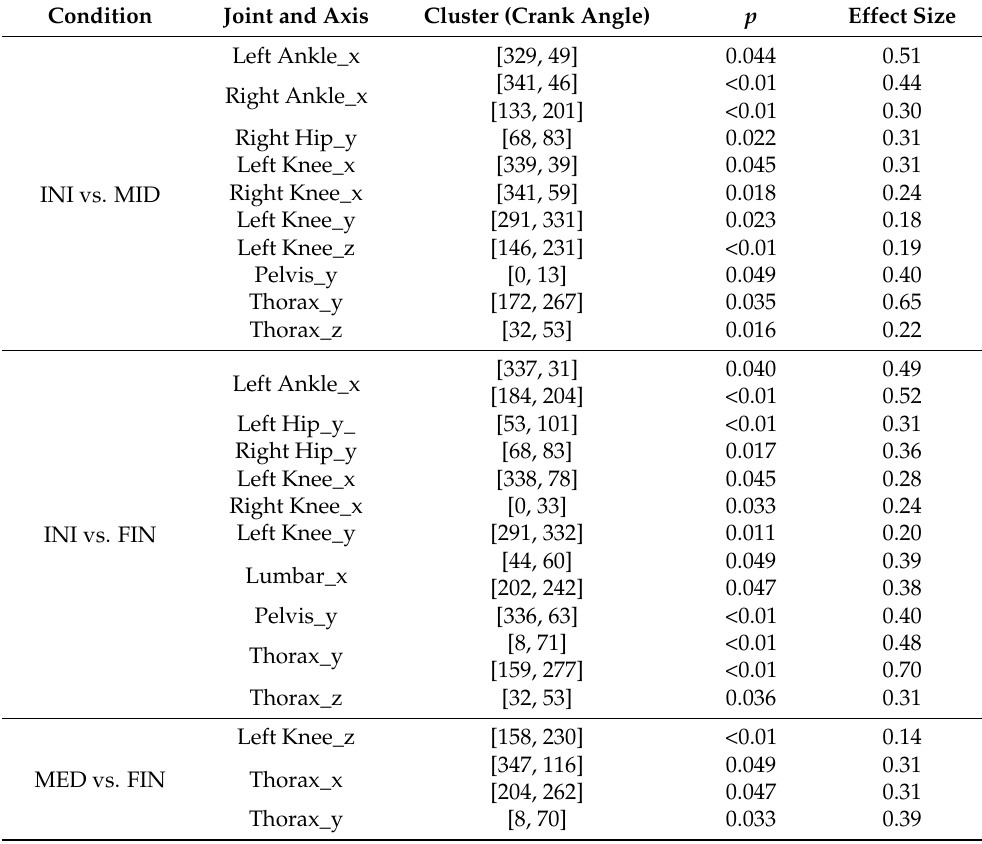
Table 1. Post hoc comparisons between the ANOVA conditions of the functional threshold power (FTP) representing the joints axis and the clusters where these differences were found. INI: measure- ment at 0 min, MID: measurement at 10 min, FIN: measurement at 20 min. x, y, z: movement in the sagittal, frontal, and transverse plane, respectively. Condition Joint and Axis Cluster (Crank Angle) p